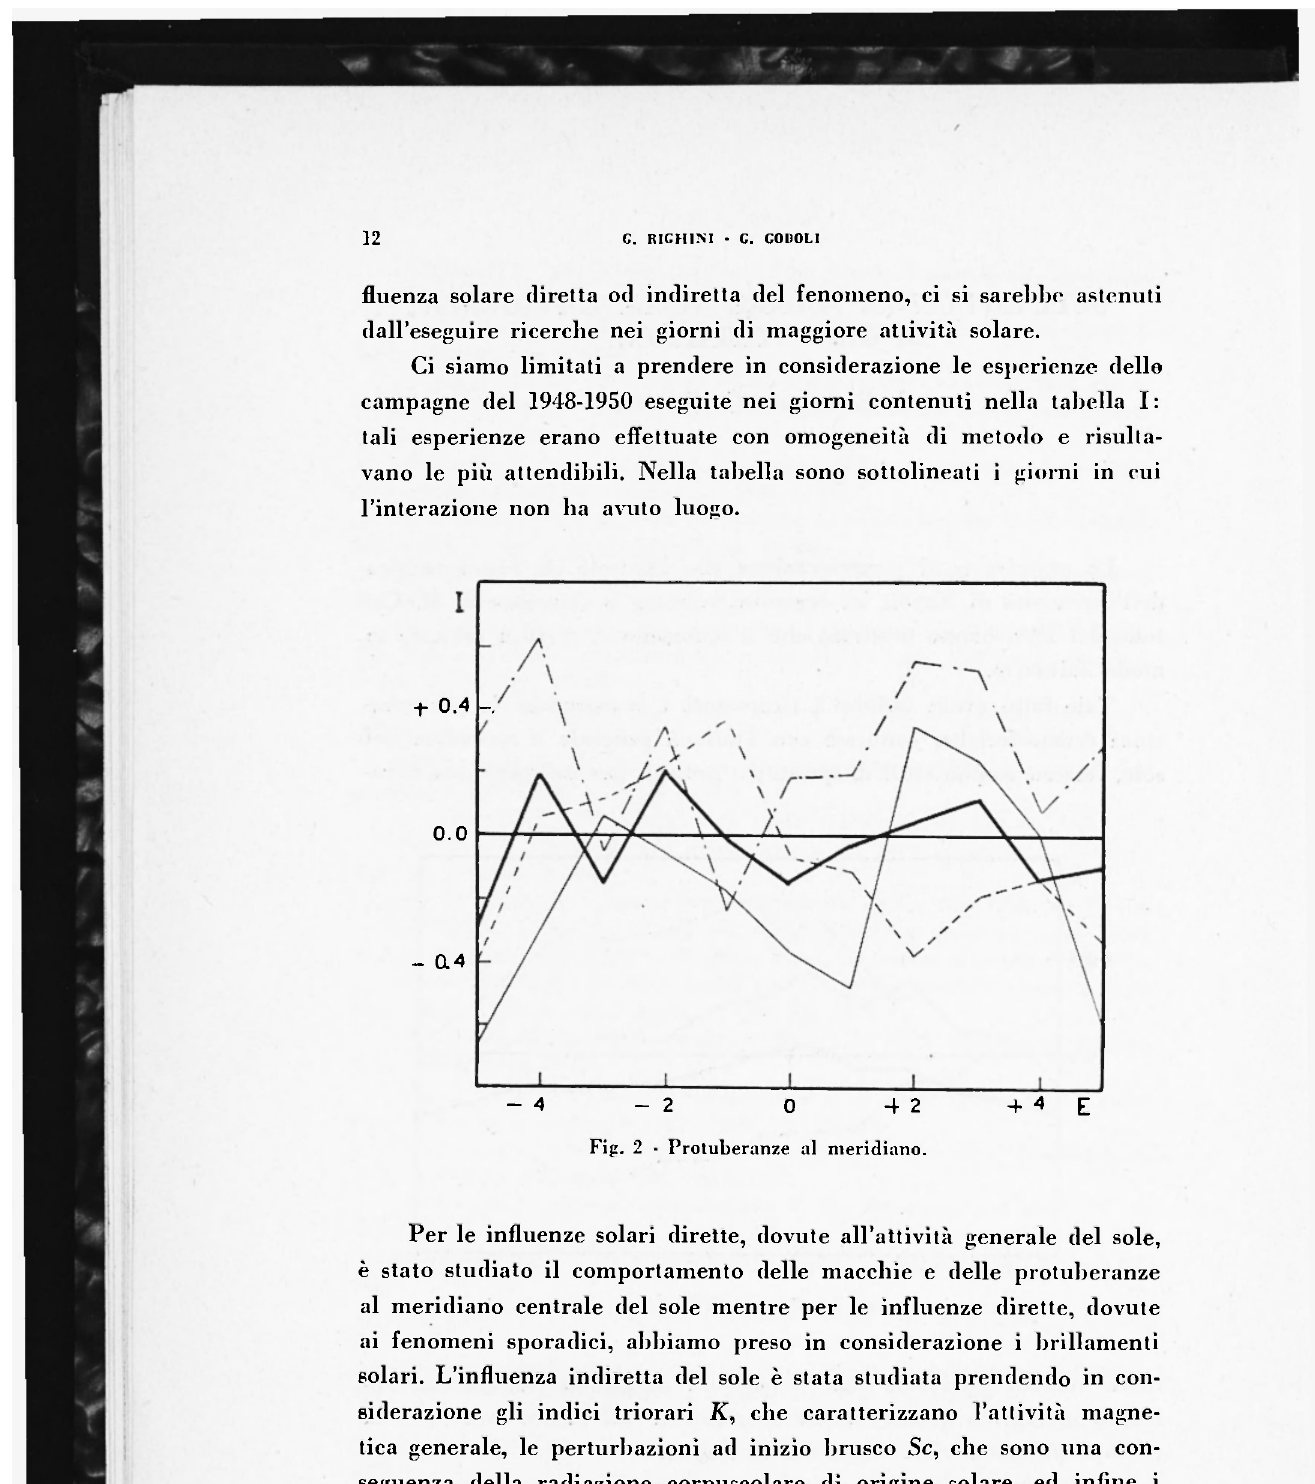
Fig. 2 - Protuberanze al